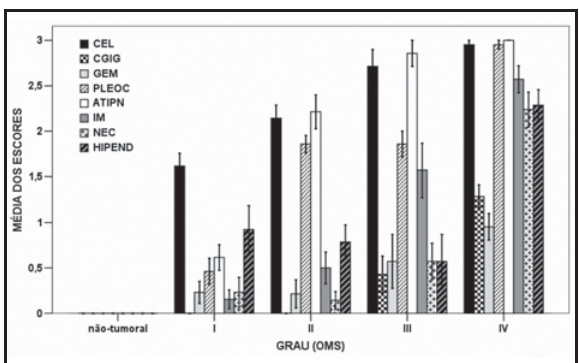
Figura 3 – Médias dos escores atribuídos aos parâmetros histopatológicos segundo a classificação histológica dos casos avaliados; ( (cid:105) ) p < 0,01; (*) p < 0,05 em relação ao grupo anterior (teste U de